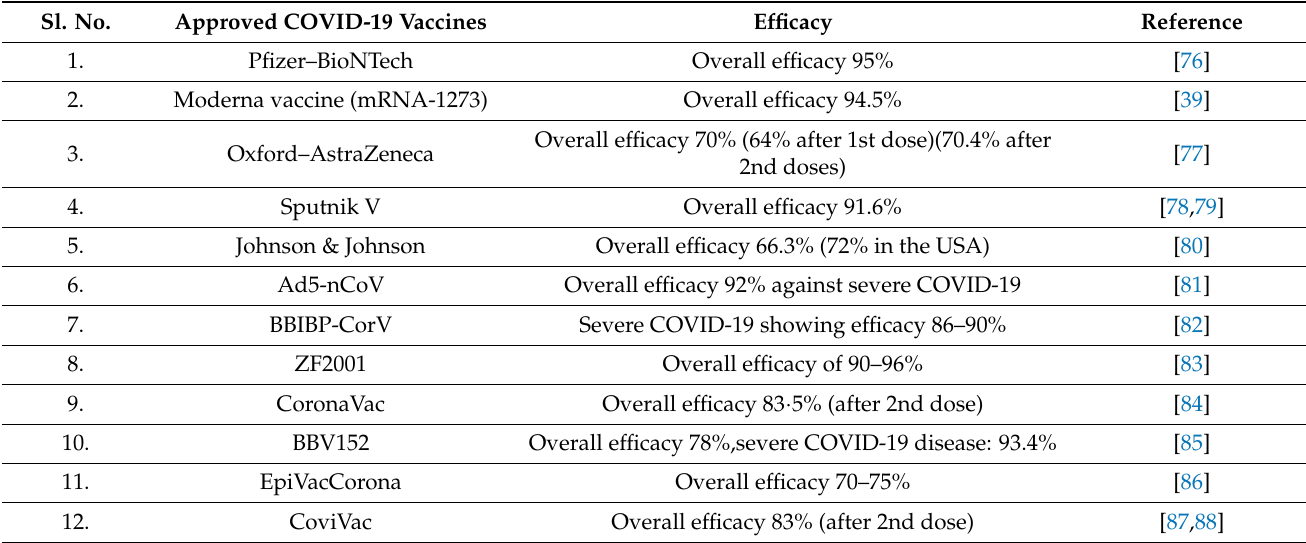
Table 2. Approved COVID-19 vaccines and their